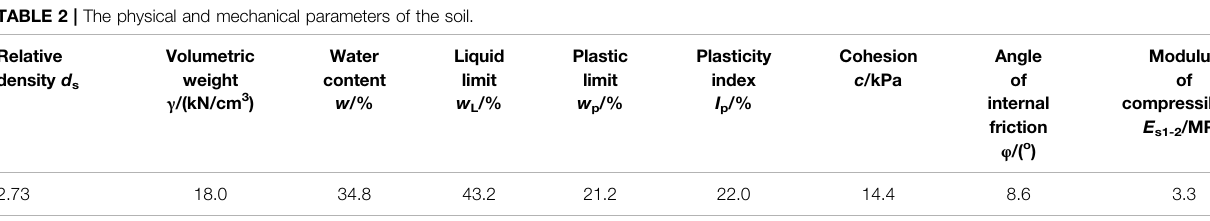
TABLE 2 | The physical and mechanical parameters of the soil. Relative density d s